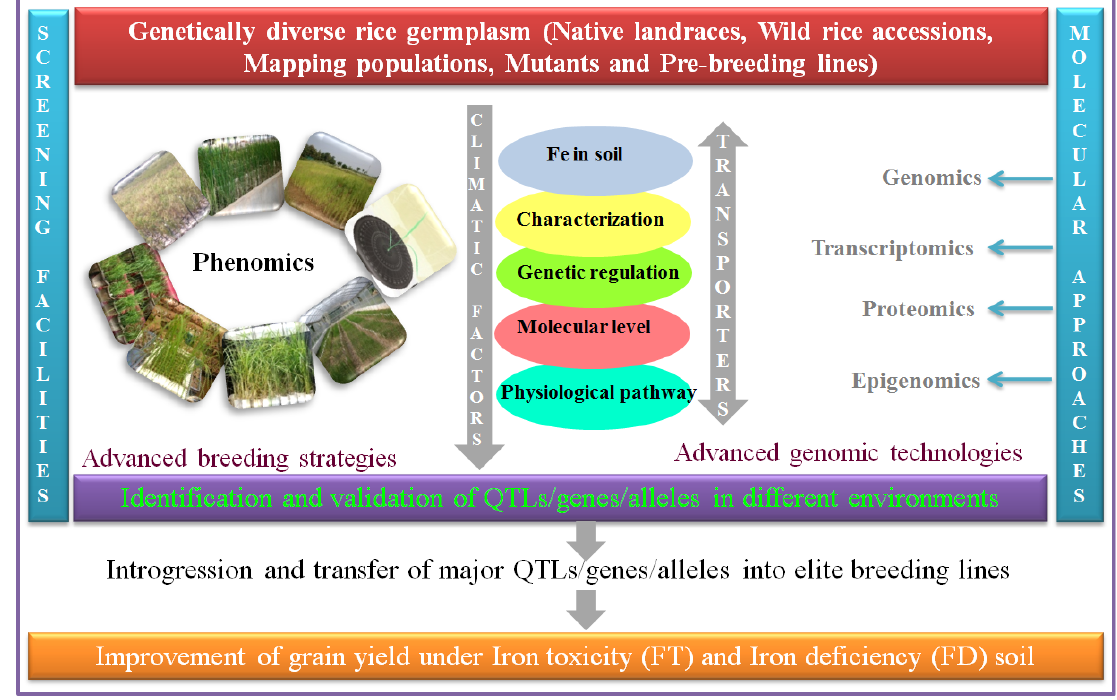
Figure 2. Schematic representation of innumerable phenotypic screening methodologies, and omics-based approaches to enhance FD/FT tolerance in rice cultivars.